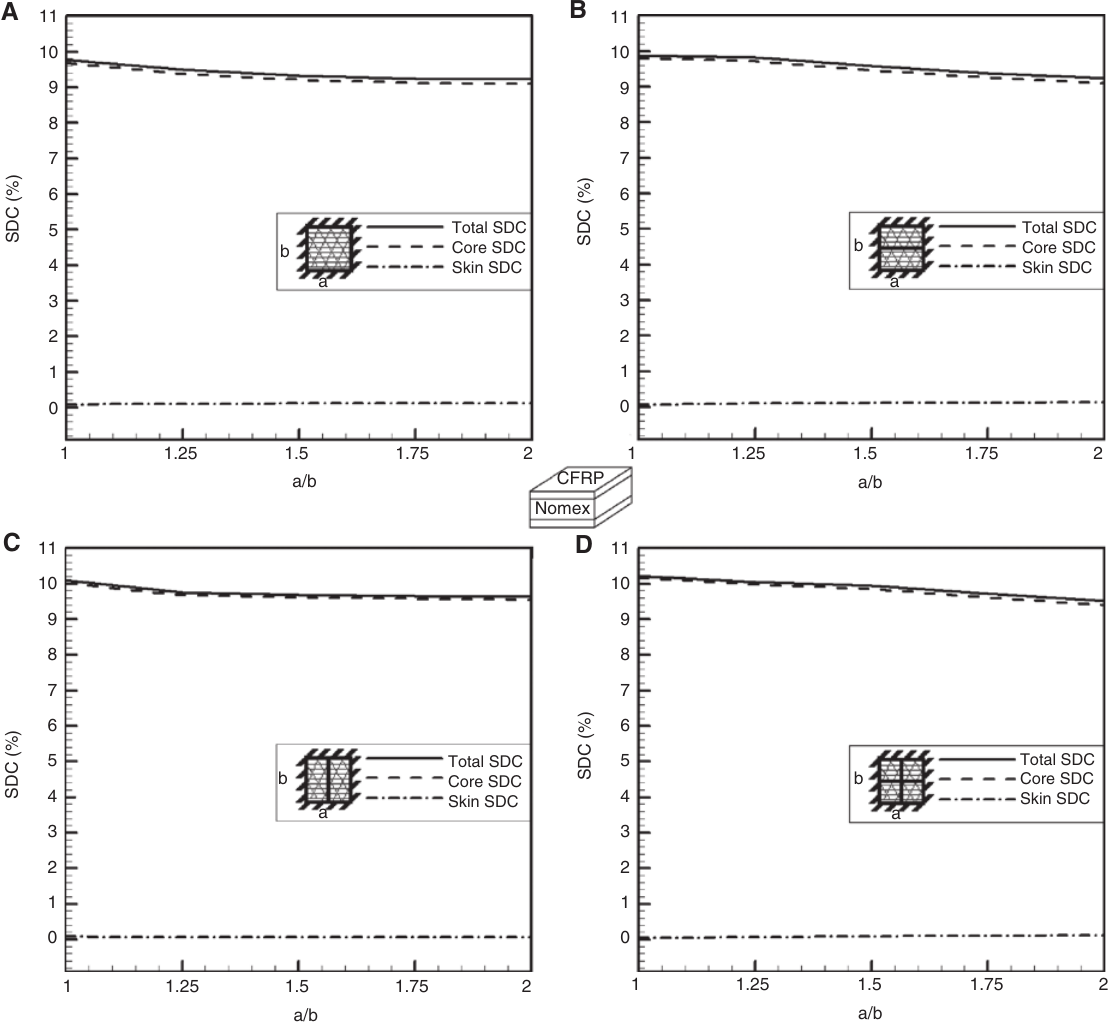
Figure 7: Damping of an all-clamped, [− 60, 0, 60] CFRP/Nomex honeycomb sandwich panel versus aspect ratio, in various modes. (A) First mode, (B) second mode, (C) third mode, (D) fourth